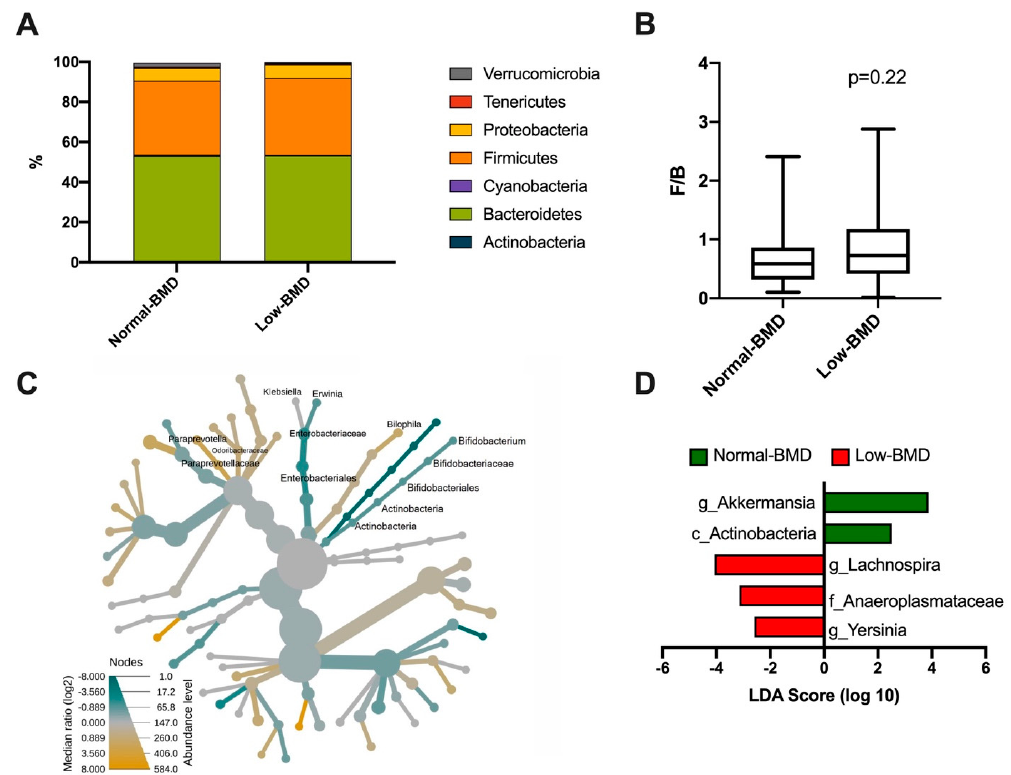
Figure 2. Bacterial taxonomy in normal-BMD and low-BMD postmenopausal women. A total of seven phyla dominated the microbiota composition in both groups, the predominant phyla were Bacteroidetes , colored green, followed by Firmicutes , colored orange ( A ). About the Firmicutes / Bacteroidetes (F/B) ratio, no statistical difference between the groups was found ( B ) ( p = 0.22). ( C ) Heat tree for pair-wise comparison. The color of each taxon indicates the log-2 ratio of proportions observed in each condition. Only those taxa that were statistically significant using the Wilcox rank sum test followed by a Benjamin–Hochberg correction (FDR) for multiple comparisons are shown colored. γ - Proteobacteria colored green, specifically the Klebsiella and Erwinia genus, were enriched in the low-BMD group; meanwhile, the Bilophila and Bacteroidales group colored yellow were enriched in the normal-BMD group. ( D ) Bacterial taxa differentially represented between groups identified by the linear discriminant analysis (LDA) effect size. Only taxa with an alpha value of 0.05 and with an LDA score of at least 2 are shown. Lachnospira , Anaeroplasmataceae , and Yersinia were enriched in the low-BMD group, while Akkermansia and Actinobacteria were overrepresented in the normal-BMD group.